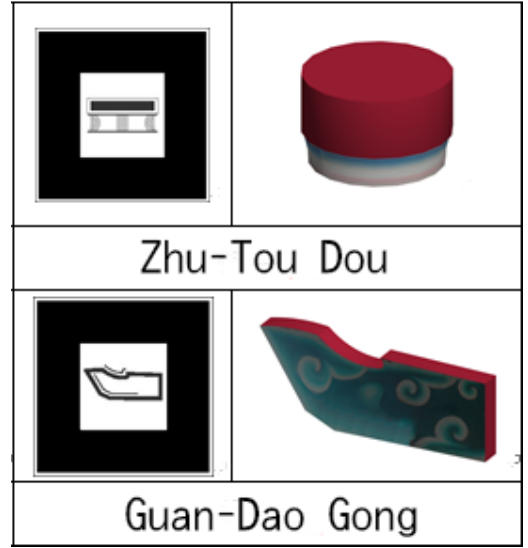
Figure 15. Zhu-Tau Dou and Guan-Dao Gong